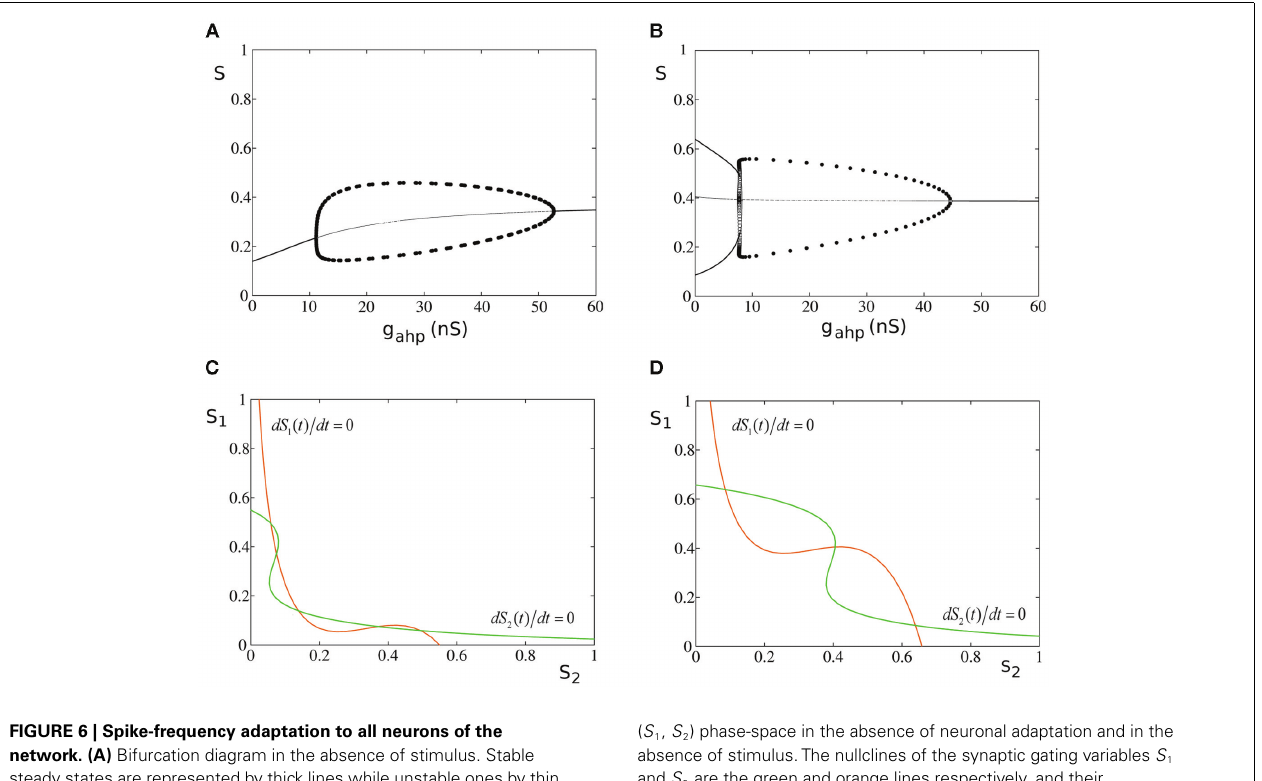
( S 1 , S 2 ) phase-space in the absence of neuronal adaptation and in the absence of stimulus.The nullclines of the synaptic gating variables S 1 and S 2 are the green and orange lines respectively, and their intersections define the stable and unstable steady states. (D) ( S 1 , S 2 ) phase-space in the absence of neuronal adaptation but in the presence of